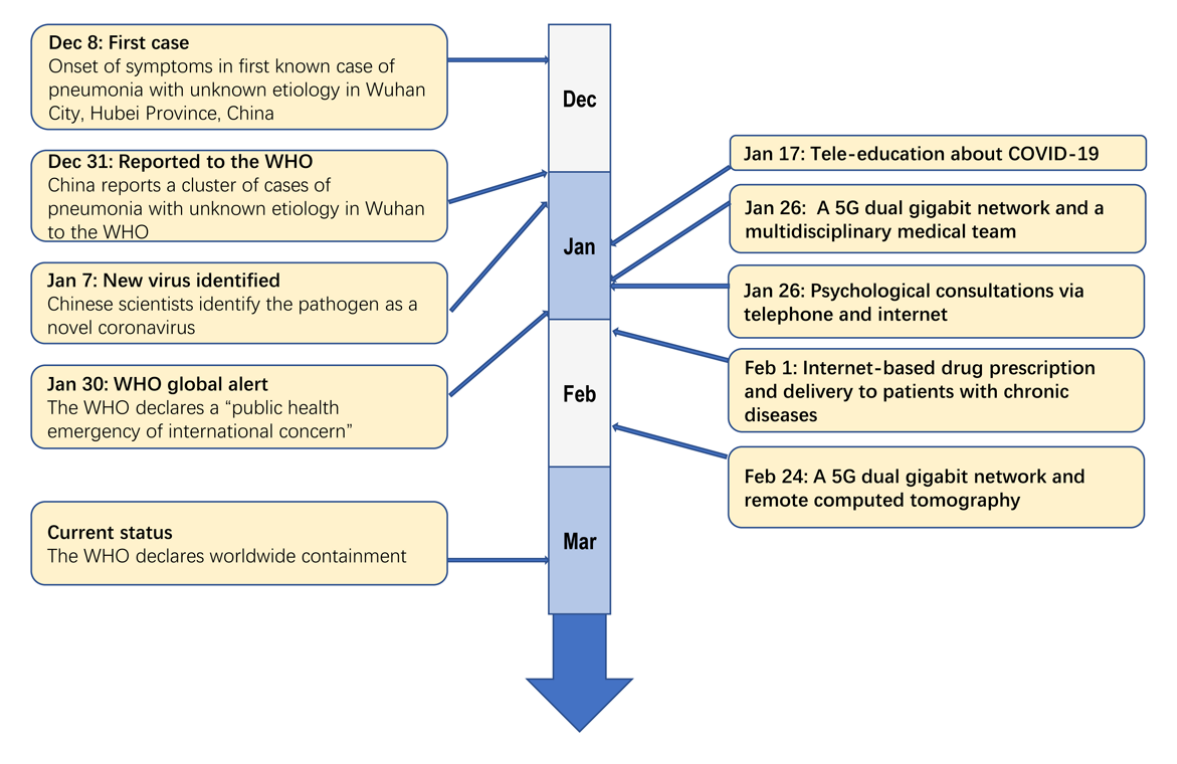
Figure 1. Progression of telemedicine in Western China during the coronavirus disease (COVID-19) pandemic. Left: timeline of COVID-19 events since the first case was reported on December 8, 2019. Right: timeline of telemedicine milestones in Sichuan Province of Western China during the COVID-19 pandemic. WHO: World Health